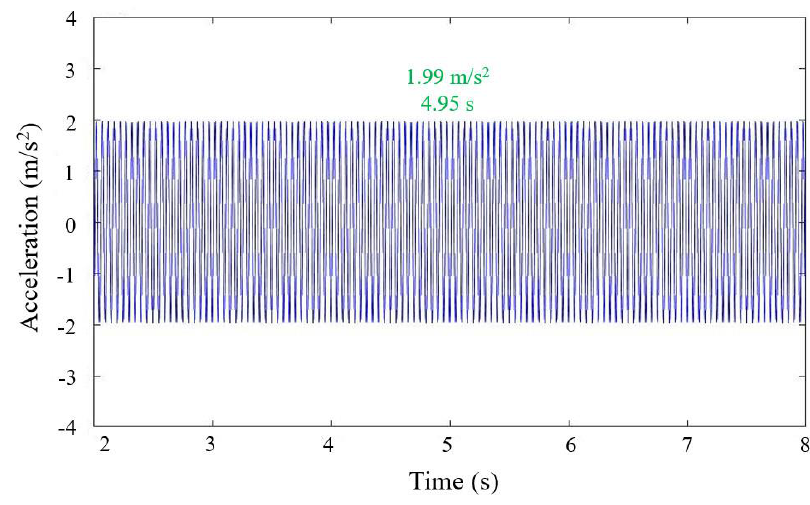
Figure 6. The experimental acceleration of the test point.